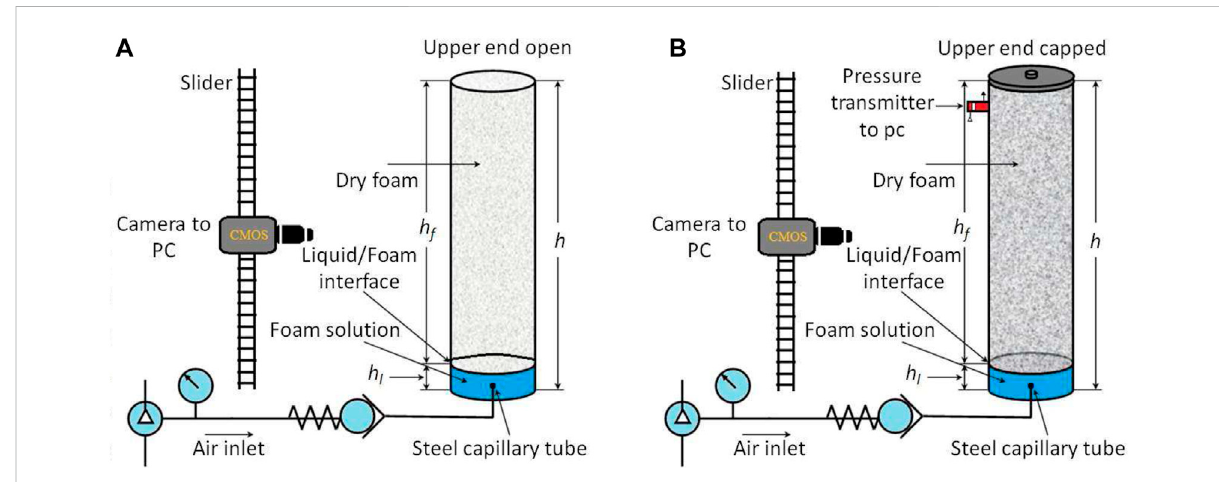
FIGURE 1 Schematicdrawingoftheexperimentalrig. (A) Opentoppipeand (B) closed-toppipe.Thegrayregionabovetheliquid fi lmofheight h l =10 cm in both vertical pipes indicates the presence of